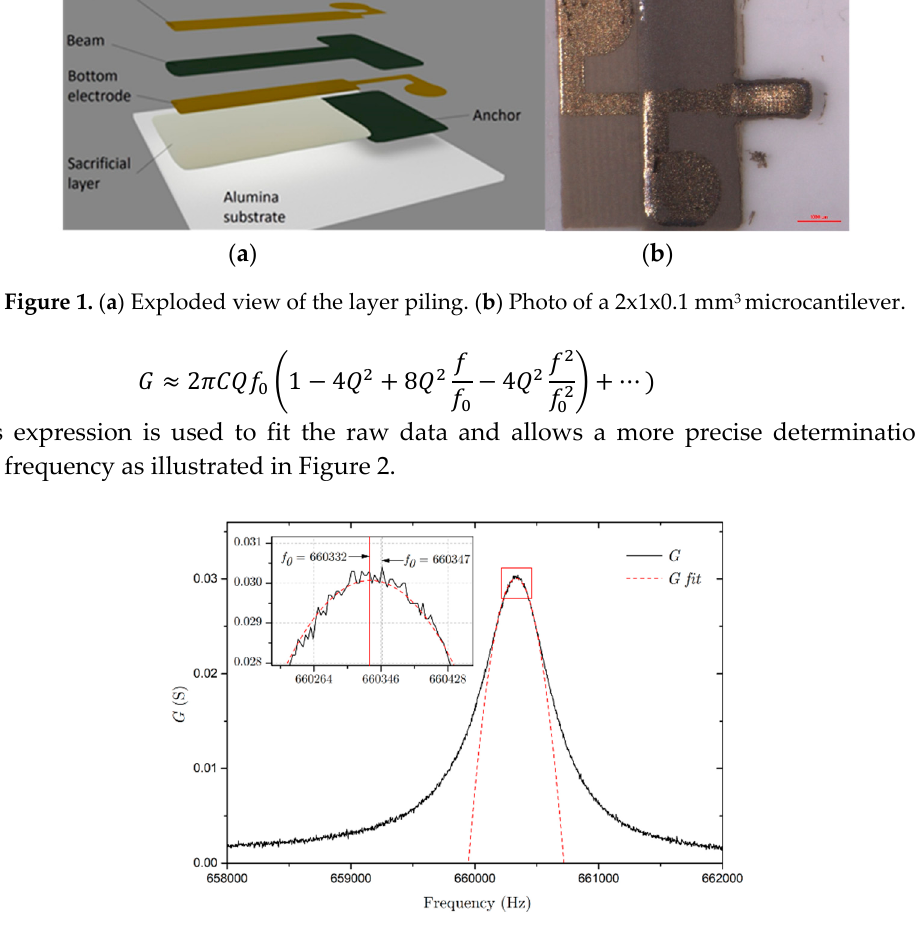
Figure 2. Conductance peak ( Q = 1300) at the resonance with polynomial model of G for resonant frequency